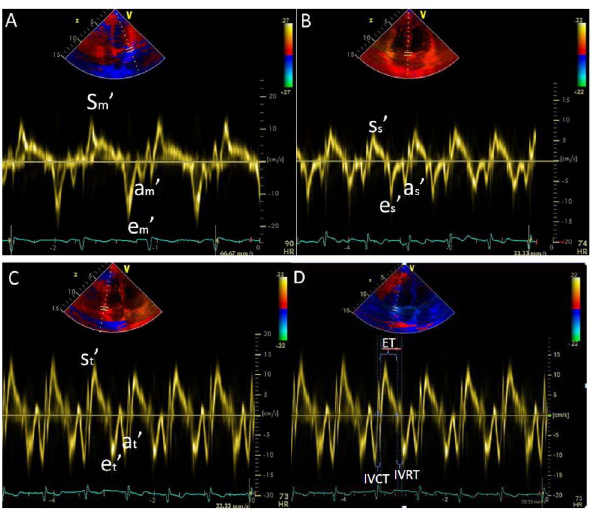
Fig. 1. Tissue Doppler at the lateral and septal walls of the mitral annulus (A, B); Tissue Doppler at the lateral wall of the Tricuspid annulus (C); Tissue Doppler of Tei Index